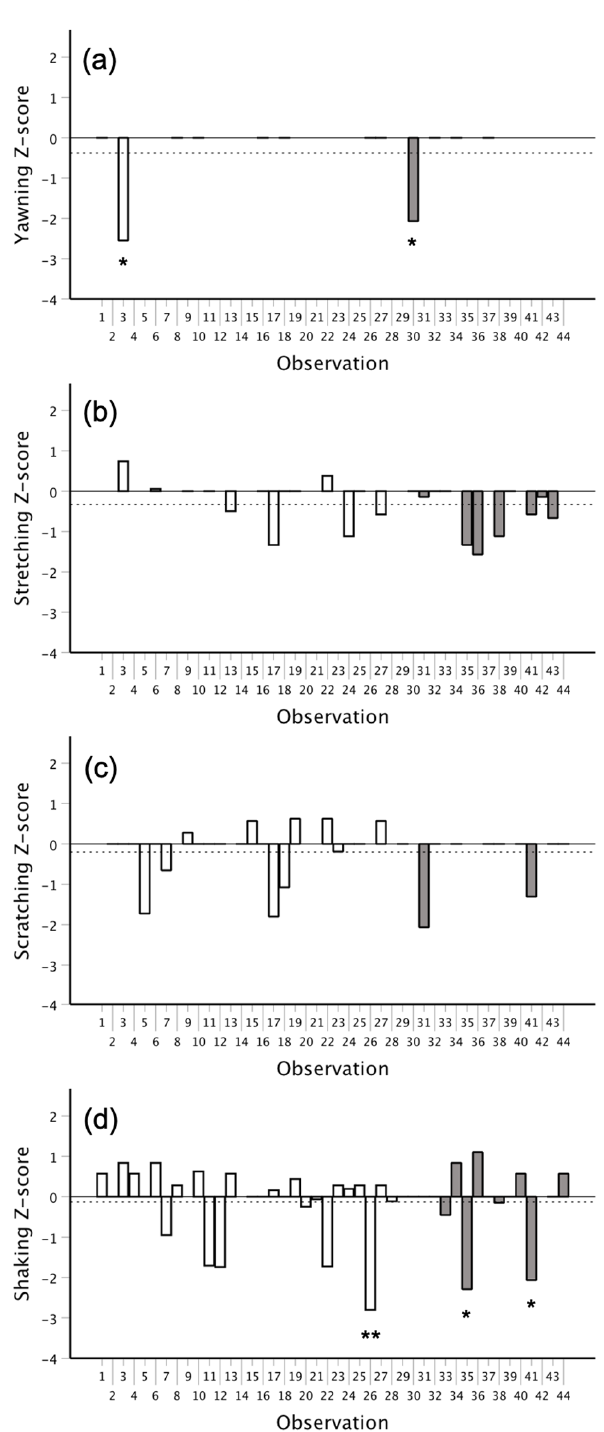
Figure 4. The distribution of Z -scores from the runs tests for ( a ) yawning ( n = 12), ( b ) stretching ( n = 24), ( c ) scratching ( n = 31), and ( d ) shaking ( n = 41) across the morning (white) and afternoon (gray) observations. The dotted line indicates the average Z -score across all observations. None of the runs tests revealed significant dispersion, but a few observations showed significant clustering. * p < 0.05; ** p < 0.01.